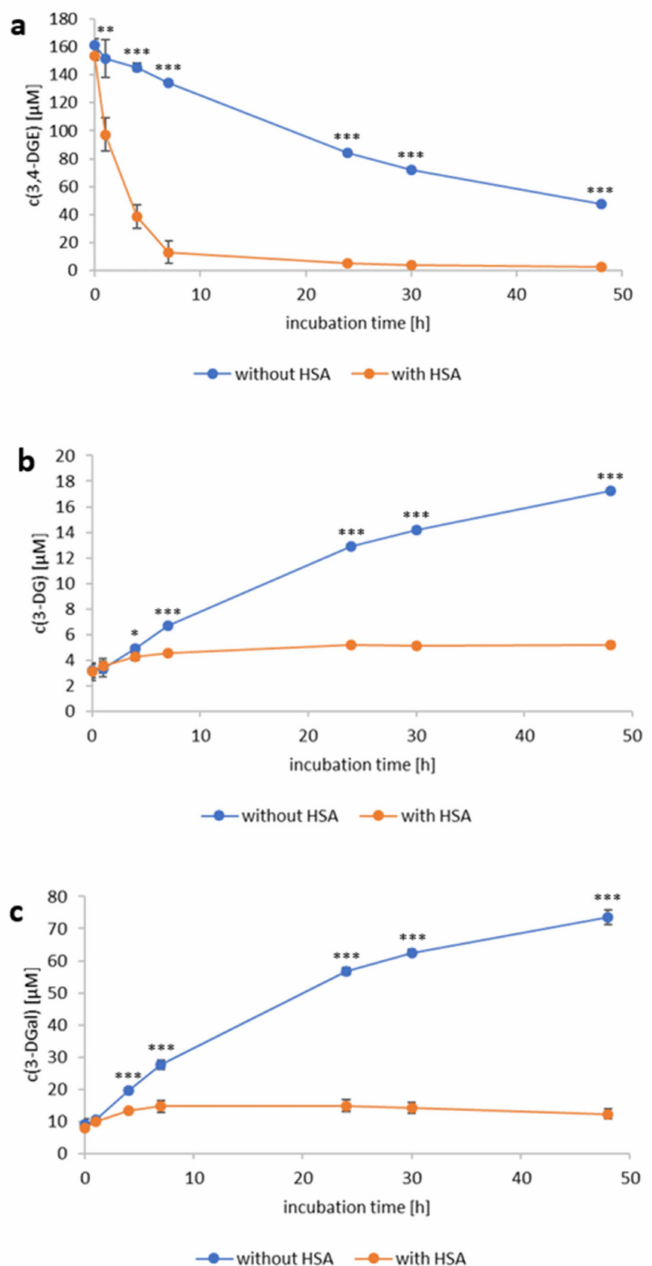
Figure 1. Human serum albumin (HSA) partially depletes 3,4-dideoxyglucosone-3-ene (3,4-DGE) from the model solution and, therefore, reduces its interconversion to 3-deoxyglucosone (3-DG) and 3-deoxygalactosone (3-DGal). 3,4-DGE (161.5 µ M, containing 3.2 µ M 3-DG and 9.1 µ M 3- DGal) was incubated for 48 h at 37 ◦ C in the absence (blue curve) or presence (orange curve) of HSA (40.0 mg/mL). The time course curves for the concentrations (in µ M, mean ± SD) of ( a ) 3,4-DGE, ( b ) 3- DG, and ( c ) 3-DGal are shown. All experiments were performed in triplicates. Significant differences between the samples with and without HSA are marked (* p < 0.05, ** p < 0.01, *** p <